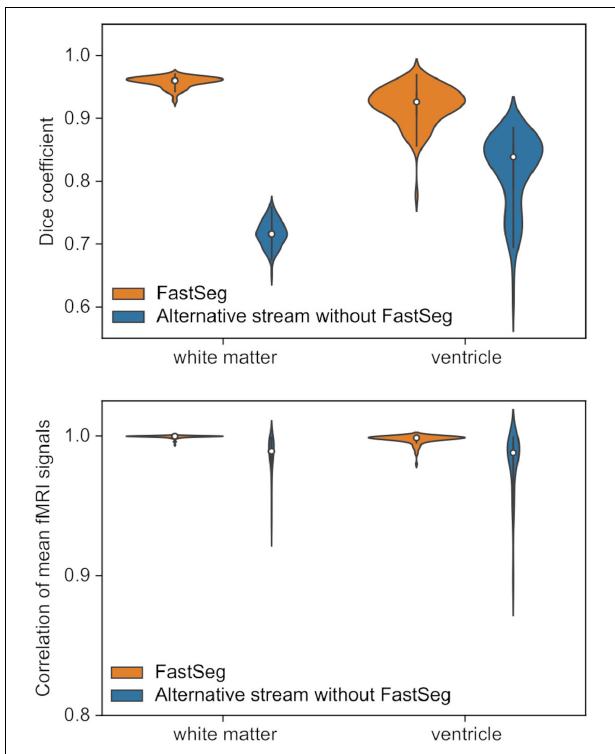
FIGURE 4 | Quality evaluations for the masks created by the RTPSpy anatomical image processing streams by comparing to FreeSurfer segmentation. The upper panel shows Dice coefficients with FreeSurfer segmentations for the white matter and ventricle masks in the anatomical image resolution. The bottom panel shows correlations of the mean signals calculated from the masks in functional